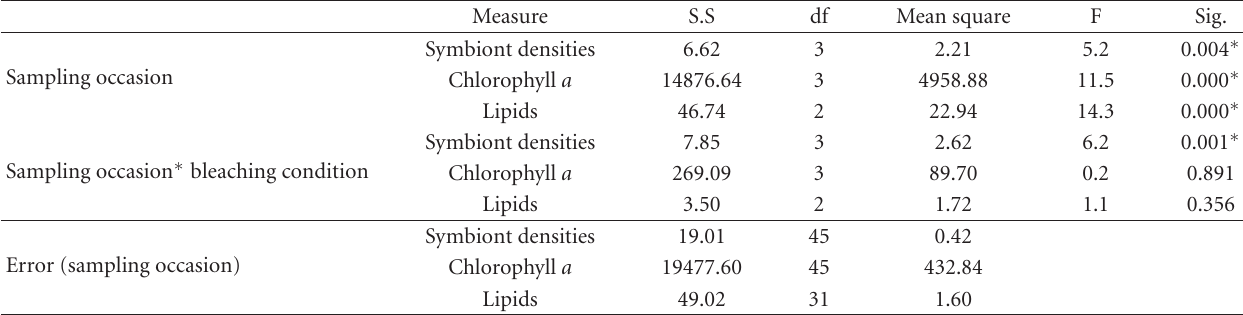
Table 4: Results of repeated measures multivariate ANOVA showing the significant e ff ect of sampling occasion (Jan, Feb, May, and Aug) on symbiont chlorophyll a content and lipids and the significant interaction between sampling occasion and bleaching condition on the symbiont densities of Acropora millepora colonies following a bleaching event in February 2006. ∗ indicate significant